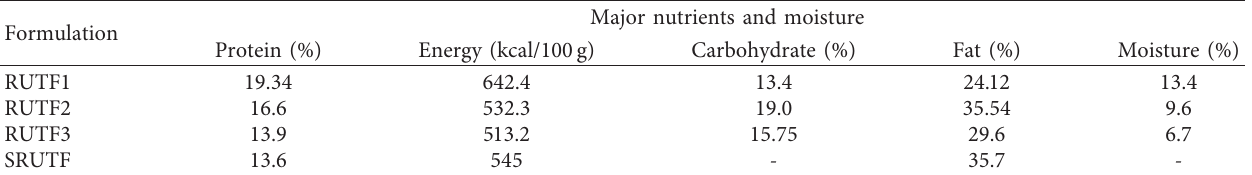
Table 2: Proximate composition of ready-to-use therapeutic